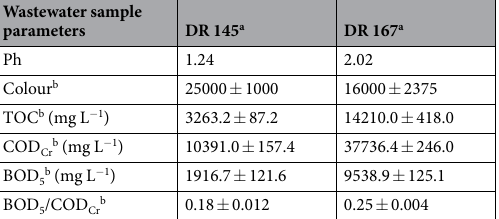
Table 1. Characteristics of dispersed dye-production wastewater. a DR 145 and DR 167 are the abbreviations of wastewater generated from the manufacturing processes of C.I. Disperse Red 145 and C.I. Disperse Red 167, respectively. b Mean ± standard deviation ( n =